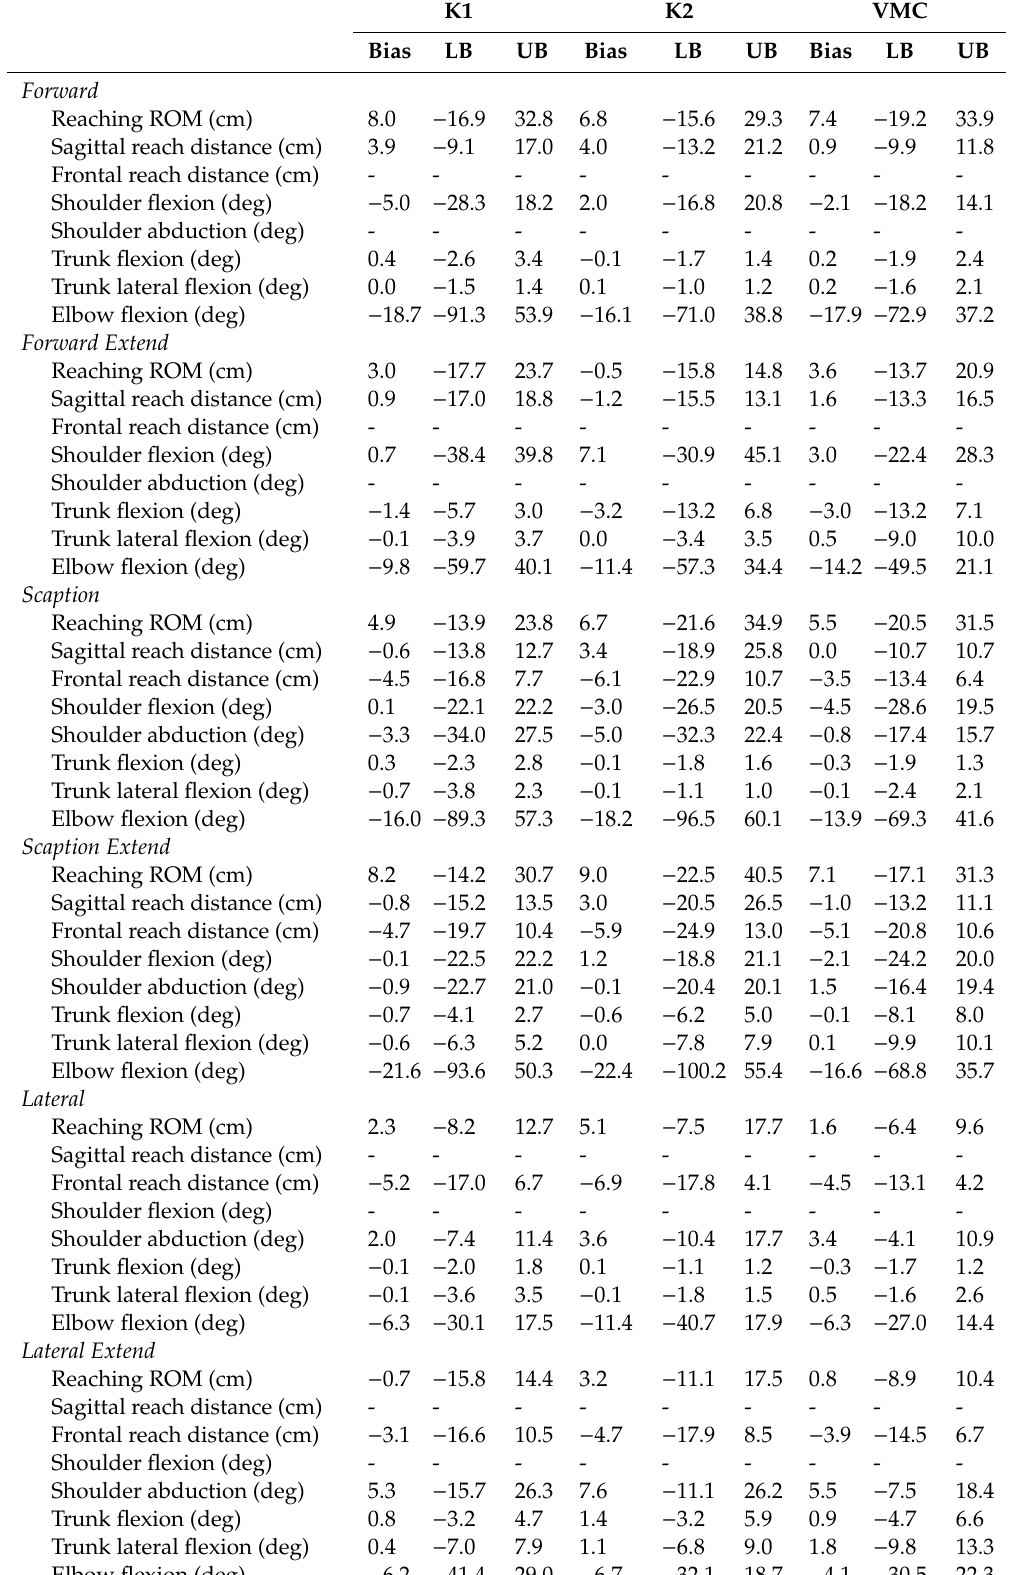
Table A4. Reliability analysis using mean bias (Bias) and Bland-Altman limits of agreement, lower bound (LB) and upper bound (LB), to compare all three sensors across testing days D1 and